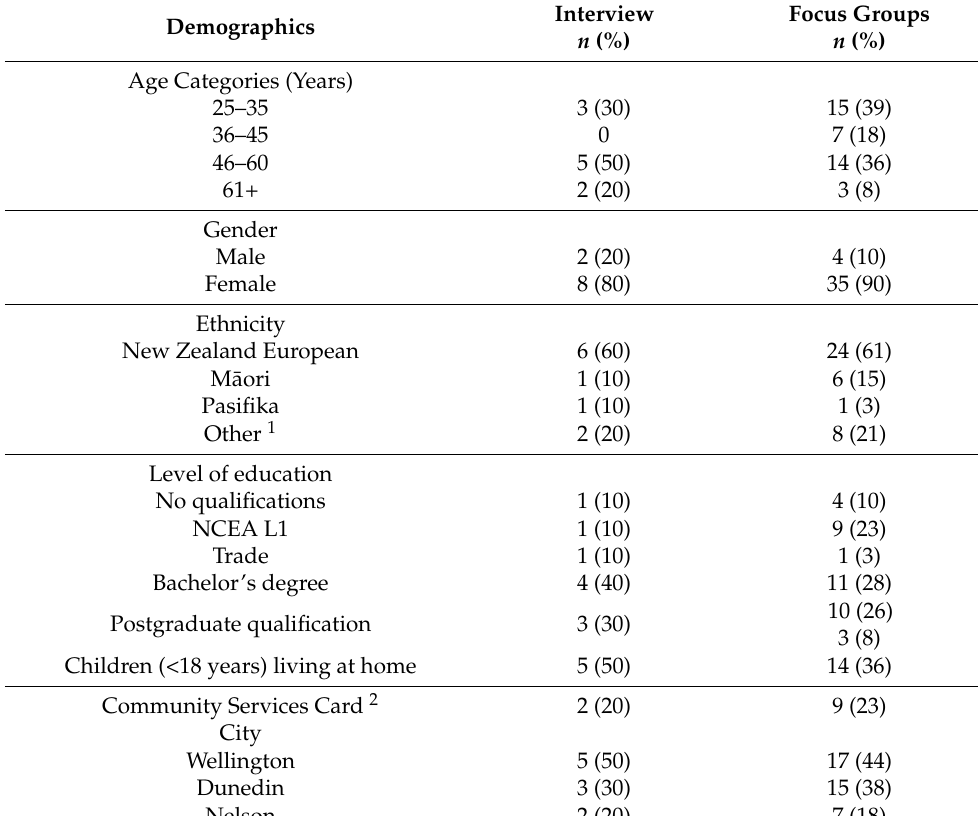
Table 2. Demographic characteristics of interview and focus group